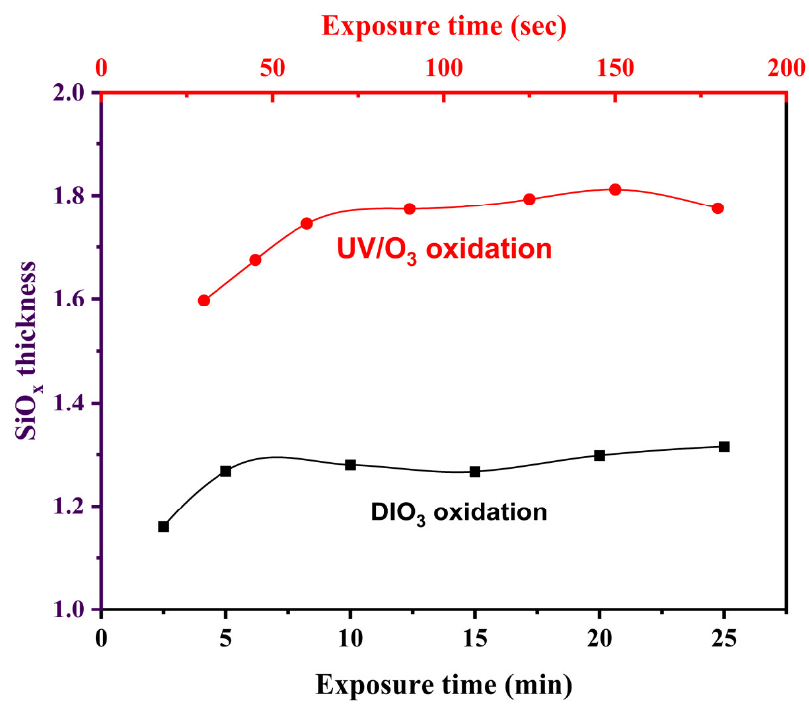
Figure 9. Thickness of the SiO x layer produced by UV and DI ozone oxidation compared with the time of exposure [80,88].